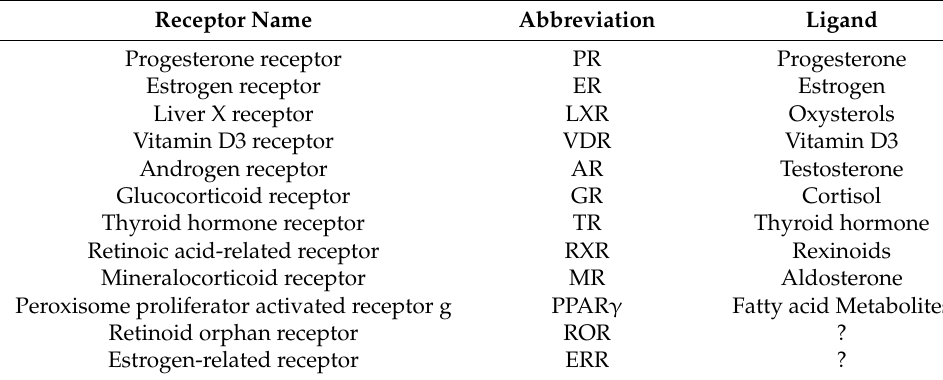
Table 1. Nuclear receptors along with their ligands [8].